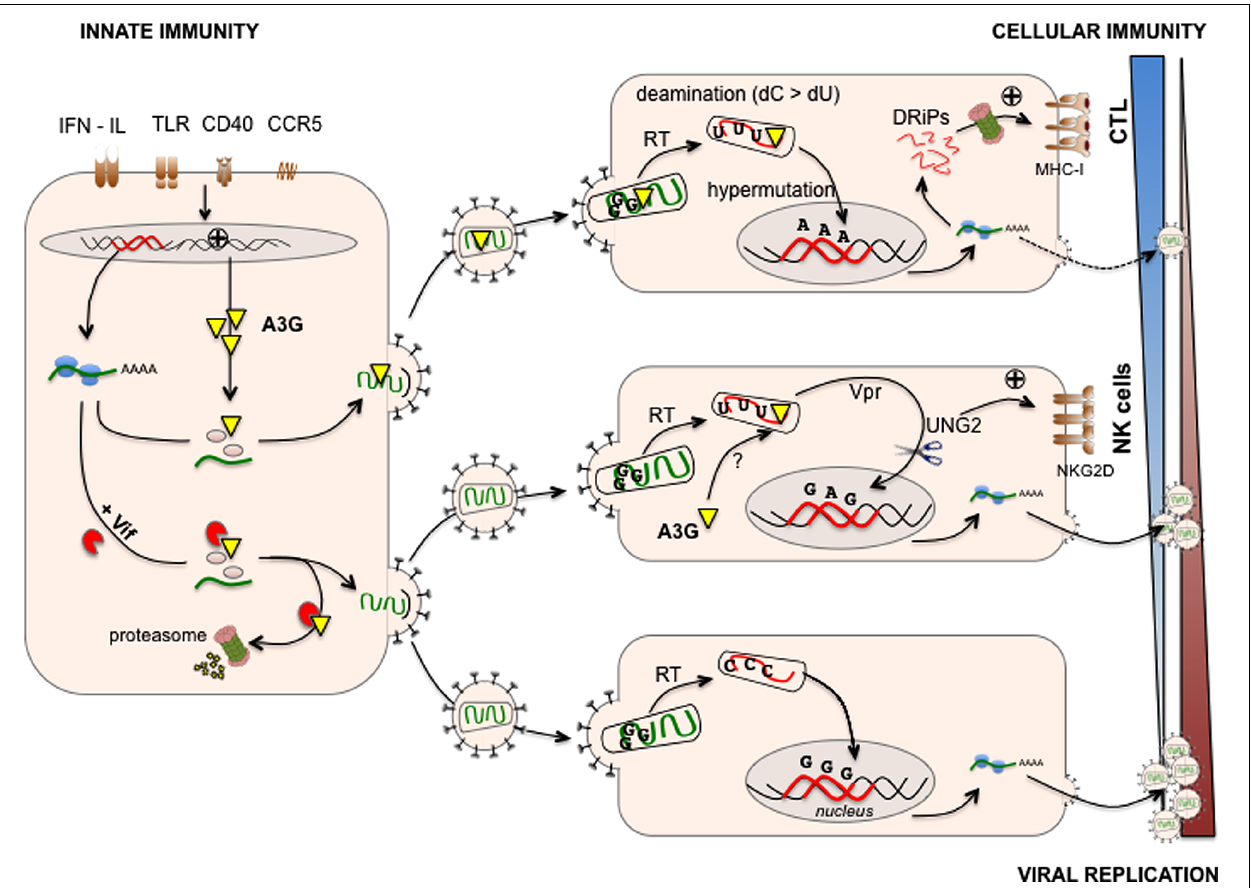
addition, deaminations lead to G to A transitions in HIV DNA leading to the integration of proviruses with a high frequency of amino acid substitutions and/or premature STOP codons. These proviruses express aberrant viral proteins that are unable to produce infectious particles. Infected cells can use these misfolded or truncated viral proteins (called DRiPs, defective ribosomal products) to generate MHC-I epitopes leading to activation of anti-HIV cytotoxic T lymphocyte (CTL) responses (right upper) . However, in infected cells, Vif counteracts the antiviral functions of A3G by targeting newly synthetized A3G for proteasomal degradation, thus reducing the amount of A3G incorporated into budding virions (left) and facilitating HIV replication in newly infected cells (right bottom) . Viral replication is therefore the result of a balance between anti-viral innate and adaptive (cellular) immunity promoted by A3G and Vif-mediated escape mechanisms developed by